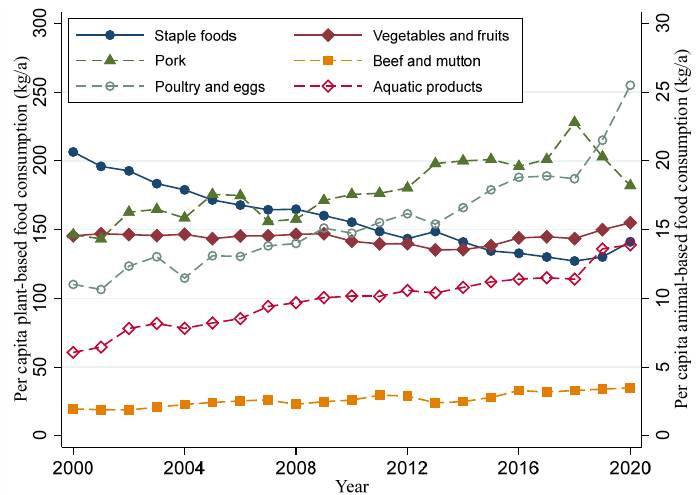
Figure 3. Per capita food consumption of various food groups from 2000 to 2020.